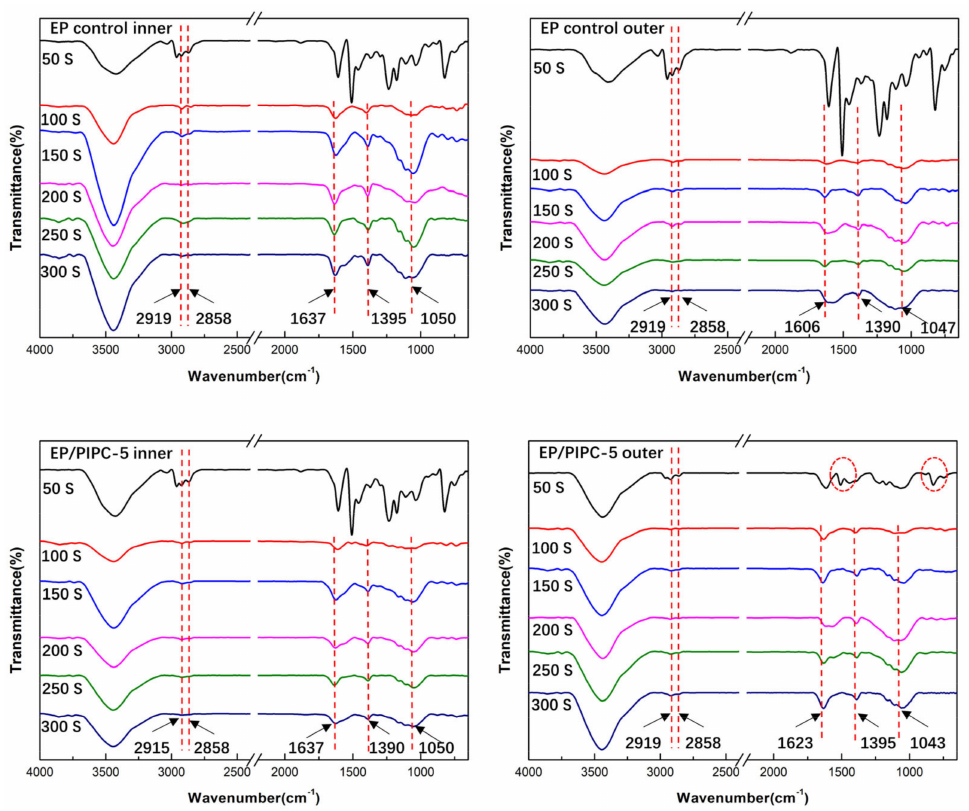
Figure 9. FTIR spectra of the condensed phase for the EP control and EP / PIPC-5 after segmented cone calorimetry test.